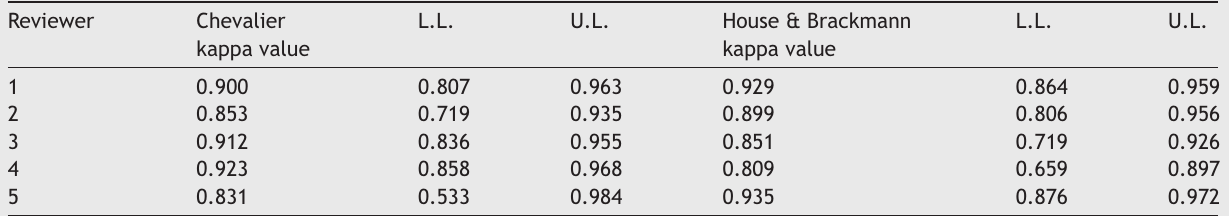
Assessment of inter-rater agreement in the interpretation of the degree of facial paralysis impairment. Reviewer